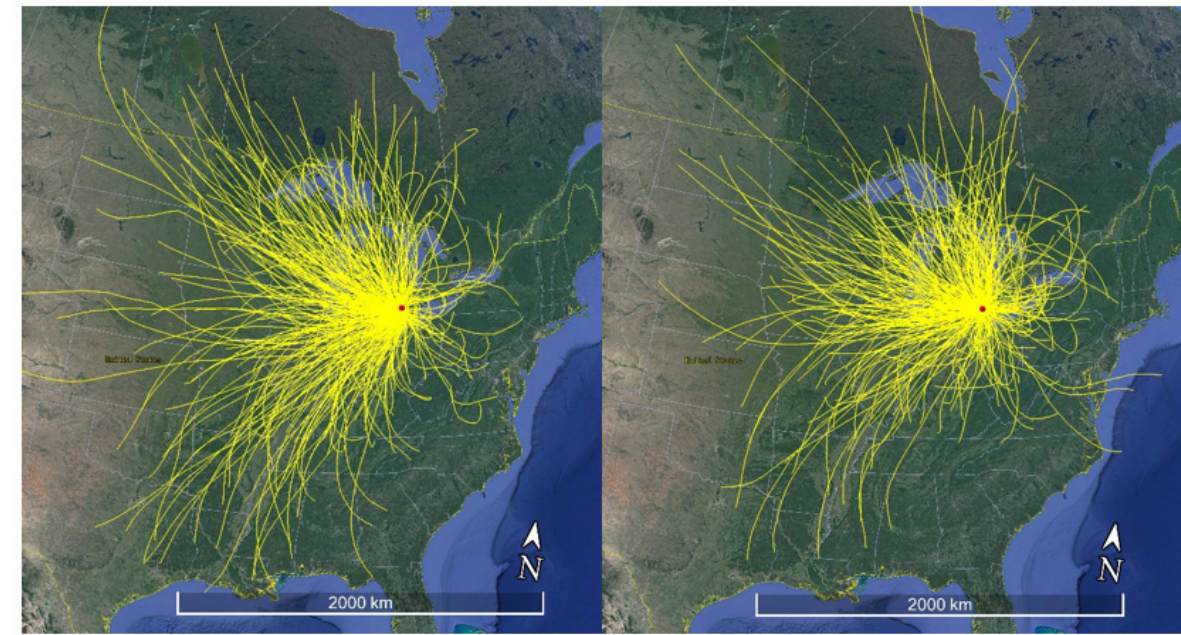
Figure 5. Back trajectories of AQHI = 3 days in cold season ( left ) and warm season ( right ). The red dots are Windsor.